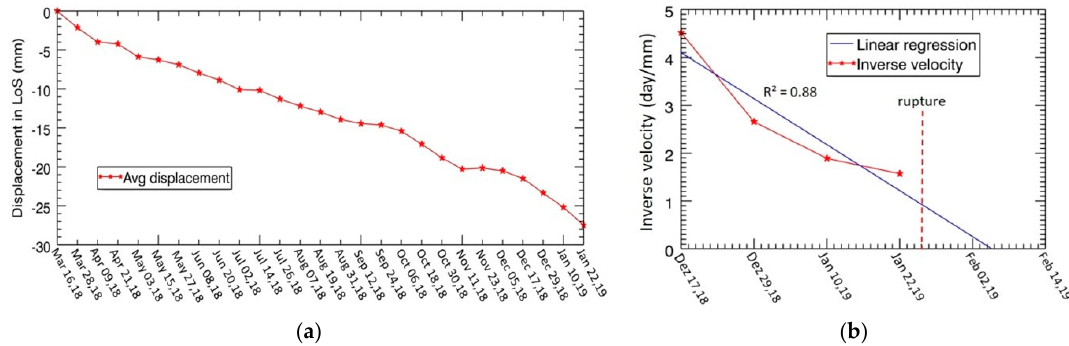
Figure 11. SBAS average displacement ( a ) and inverse of the velocity graph with linear regression ( b ).